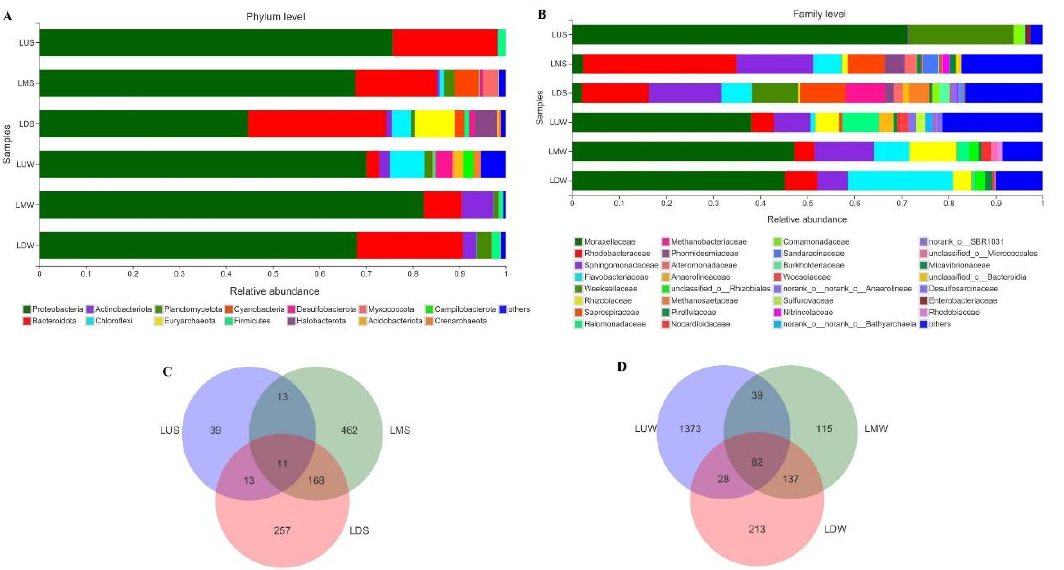
Figure 3. Relative abundance of epiphytic bacterial taxa associated with Spartina alterniflora at the phylum level ( A ) and family level ( B ). Venn map of different groups based on the ASVs in summer ( C ) and winter ( D ). LUS: summer samples of upper leaves; LMS: summer samples of middle leaves; LDS: summer samples of lower leaves; LUW: winter samples of upper leaves; LMW: winter samples of middle leaves; LDW: winter samples of lower leaves.